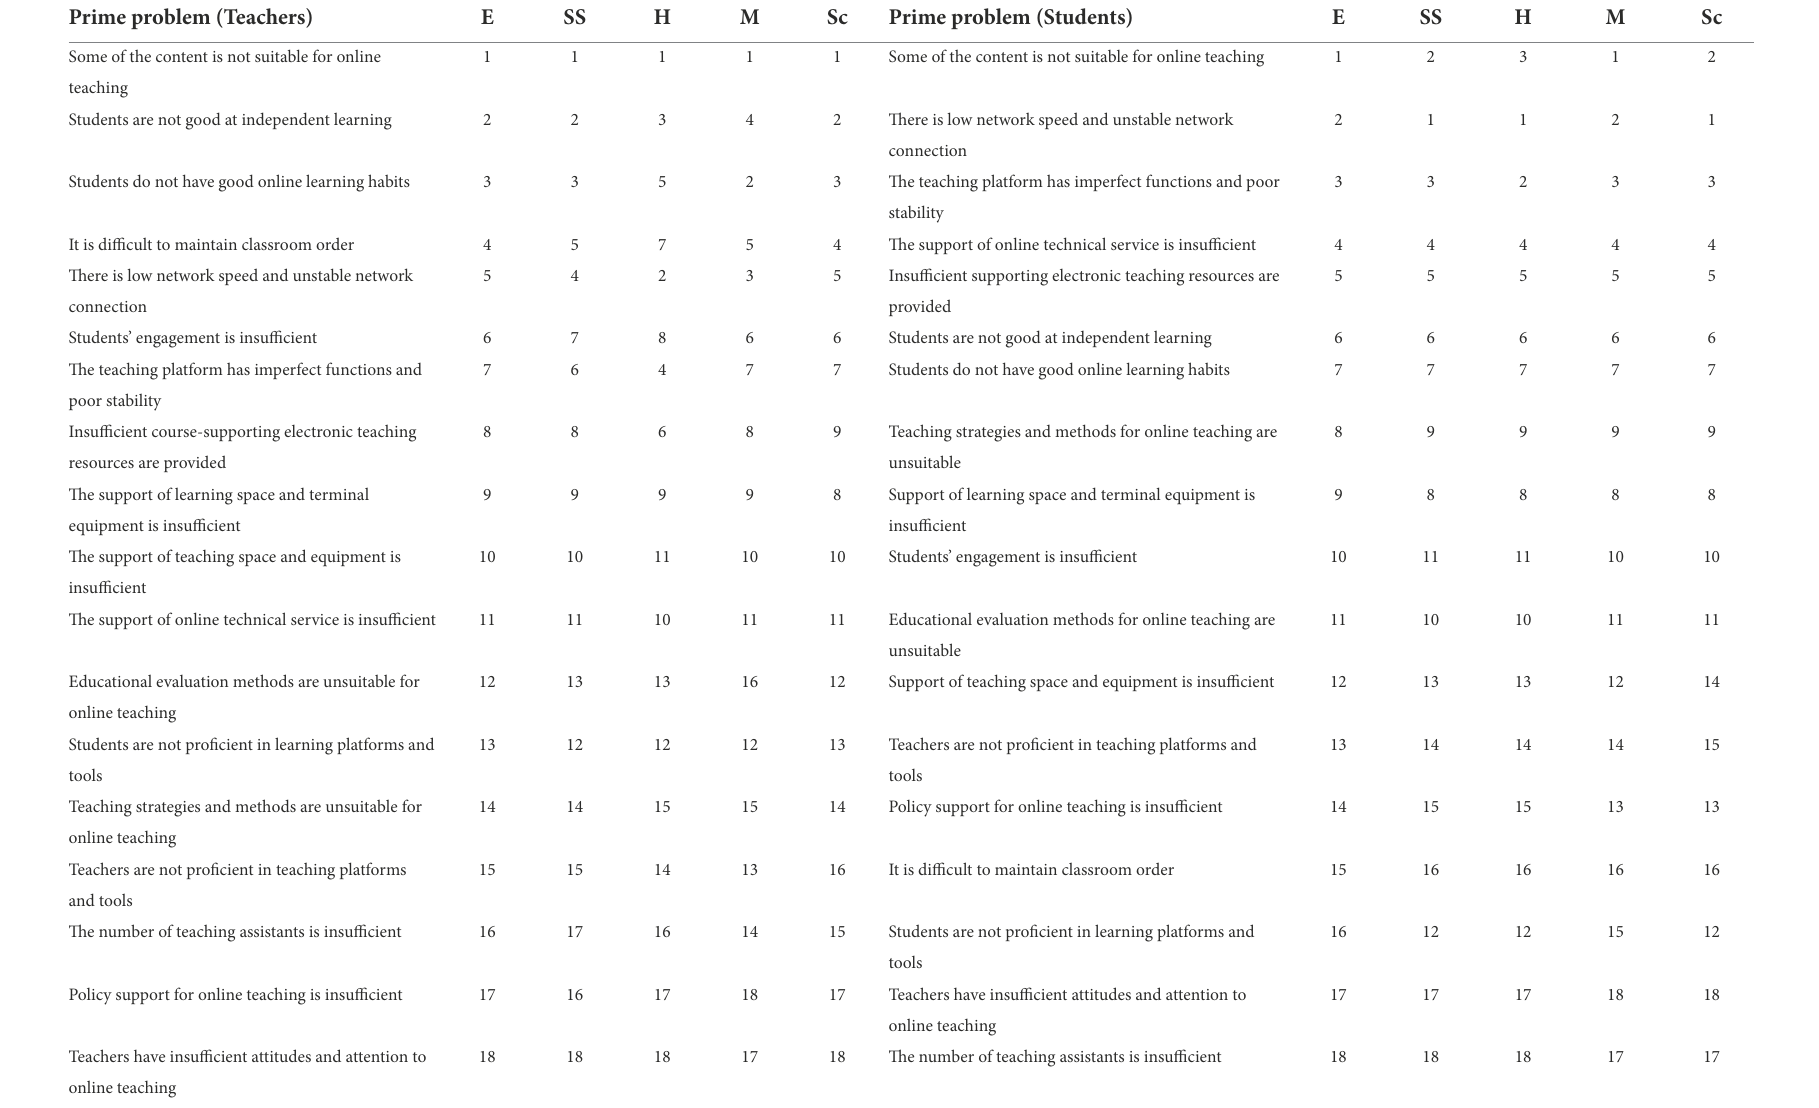
TABLE 4 Evaluation of the primary problems of online education by teachers and students of different disciplines. Prime problem